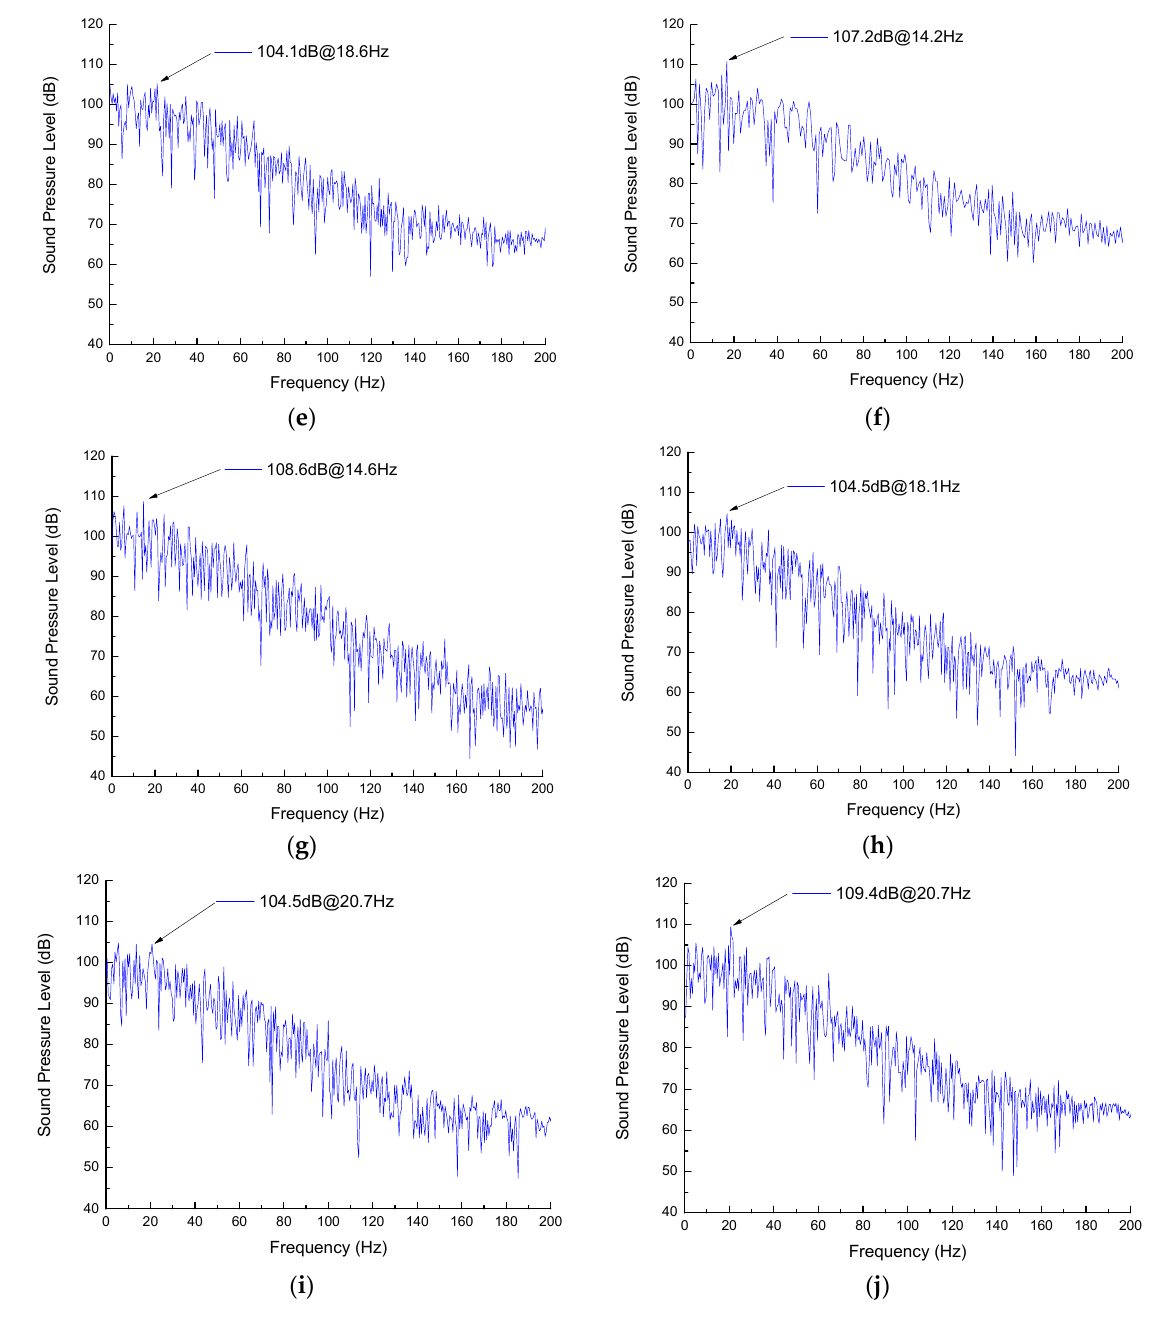
Figure 9. The sound pressure level spectrum at the driver’s left ear. ( a ) YU1; ( b ) YU2; ( c ) YU3; ( d ) YU4; ( e ) YU5; ( f ) YU6; ( g ) YU7; ( h ) YU8; ( i ) YU9; ( j ) YU10. Table 3. Analysis of fitting accuracy of approximation